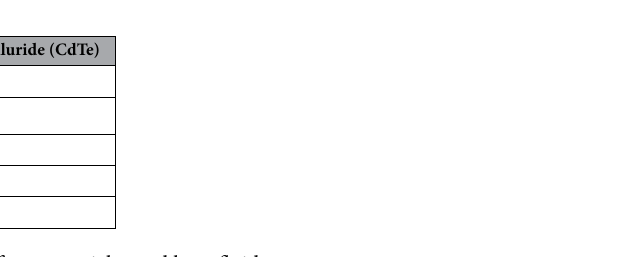
Table 1. Thermophysical properties of nanoparticles and base fluid.